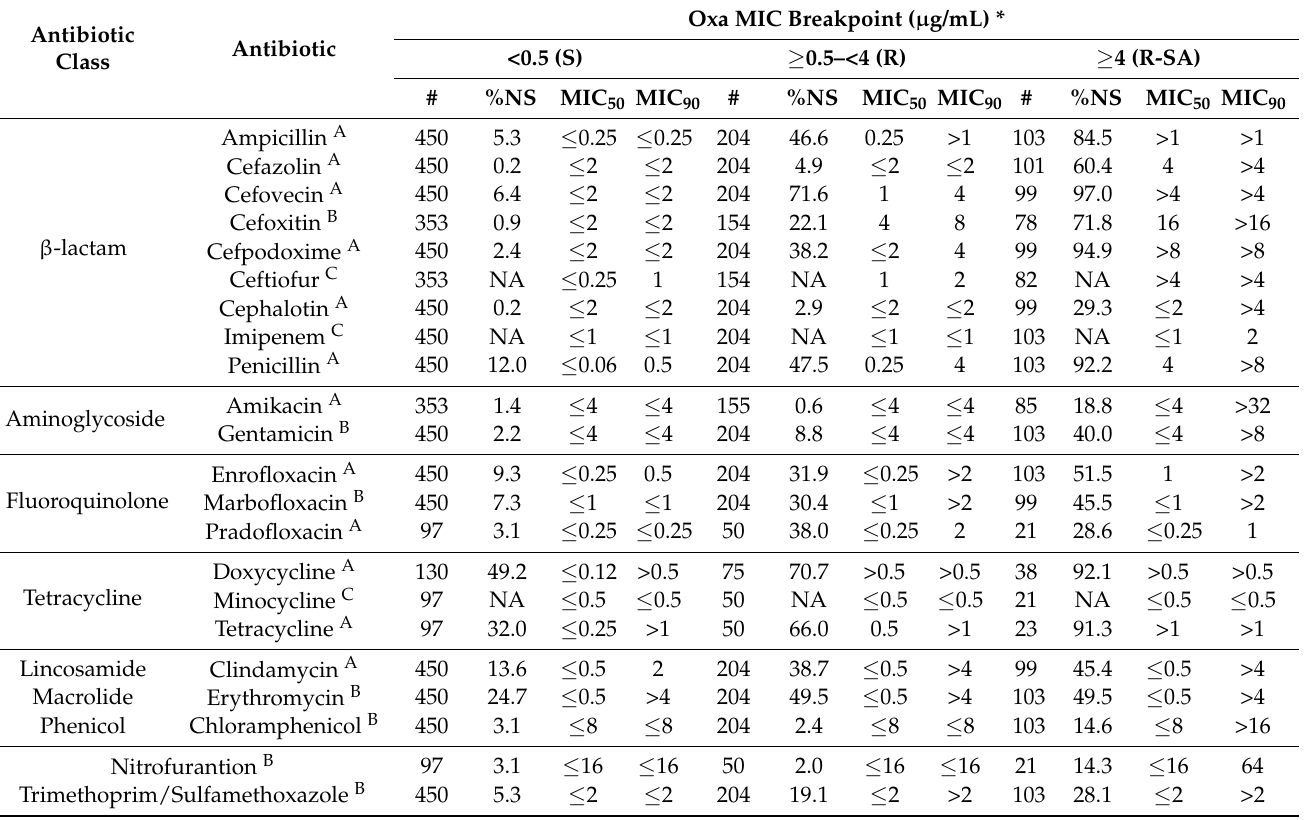
Table 2. In vitro cross-resistance patterns of coagulase-negative staphylococci (CoNS) isolates by oxacillin